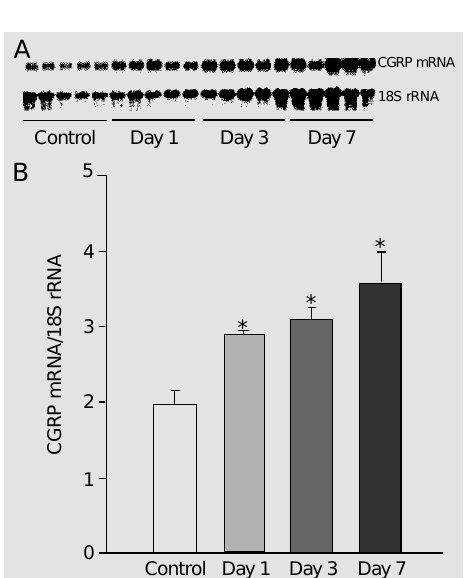
Figure 4. Calcitonin gene-related peptide (CGRP) receptor antago- nist administration increases mean arterial pressure (MAP) in the nerve growth factor (NGF)- treated but not the control spon- taneously hypertensive rats (SHR). Control (N = 8) and NGF- treated (days 1, N = 9; 3, N = 10, and 7, N = 11) SHR were instru- mented for continuous MAP recording and intravenous drug administration. With the rats fully awake and unrestrained, bolus doses of saline (200 µl) or CGRP 8-37 (800 µg/kg in 200 µl saline) were given intravenously. *P<0.05 compared to control SHR (ANOVA followed by the Tukey-Kramer multiple compari- sons